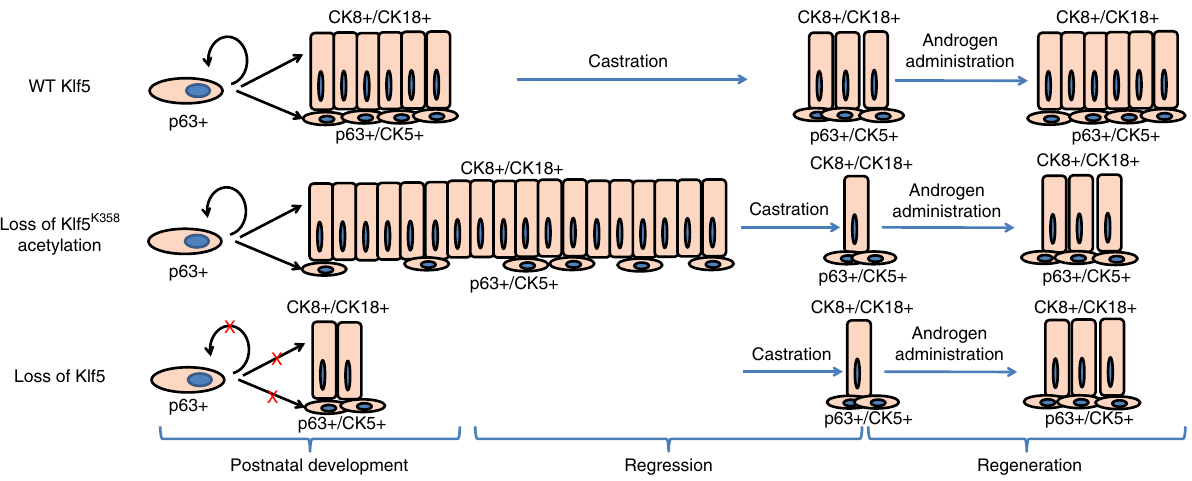
Fig. 9 KLF5 and its acetylation regulate luminal differentiation of basal progenitors. An illustrated model to depict the roles of KLF5 and its acetylation in the maintenance and proper differentiation of p63 + basal progenitor cells during postnatal development and the castration-regeneration for experimental groups (15 mg/pellet/mouse; Innovative Research of America, Sarasota, FL) or with placebo pellets for control groups. Genotyping . All mice were toe-clipped at the age of 8-12 days for labeling and genotyping. Toe tissues were incubated overnight at 56 °C with tissue lysis buffer Supplementary Table 2. The original data are provided in the Source Data fi le. Histology . Mice were euthanized at indicated time points according to the requirements of different experimental designs. A mixture of prostate, urethra, bladder and surrounding connective tissues was isolated, and then the prostate dissected from the mixture in PBS. Wet weights of prostates were measured immediately. Tissues for histopathological analysis were fi xed in 10% neutral buffered formalin overnight, transferred to 70% ethanol, embedded in paraf fi n, sectioned at 5 µm, and stained with hematoxylin and eosin (H&E) at the Research Pathology Core Lab at the Winship Cancer Institute. Patient samples . One prostate tissue microarray contains normal prostate tissues from 24 patients, obtained from US Biomax (BNS19011). Some samples were torn and/or had a dark nonspeci fi c background, and had to be excluded from the fi nal statistical analyses. Additional normal prostate specimens were obtained from the Department of Pathology, Emory University School of Medicine. All tissues are collected under the highest ethical standards with the donor being informed completely and with their consent.